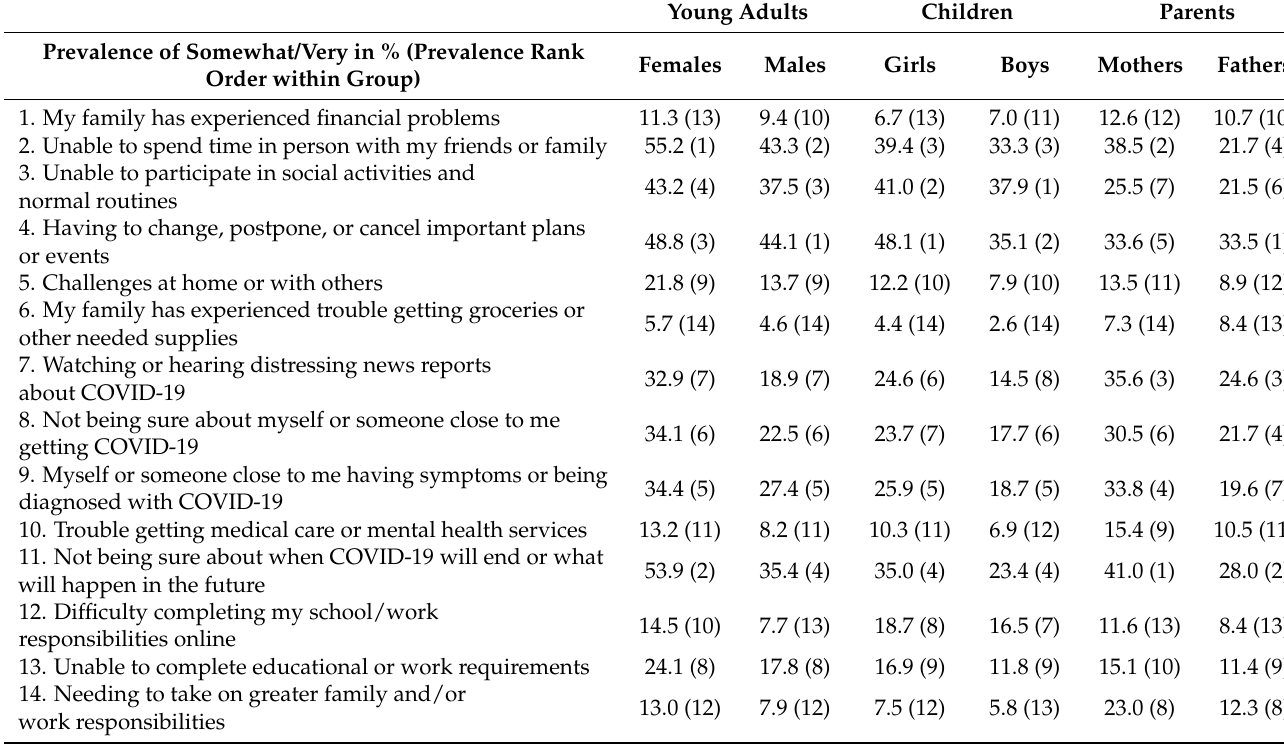
Table 2. Prevalence of perceived stress due to COVID-19 (%, rank